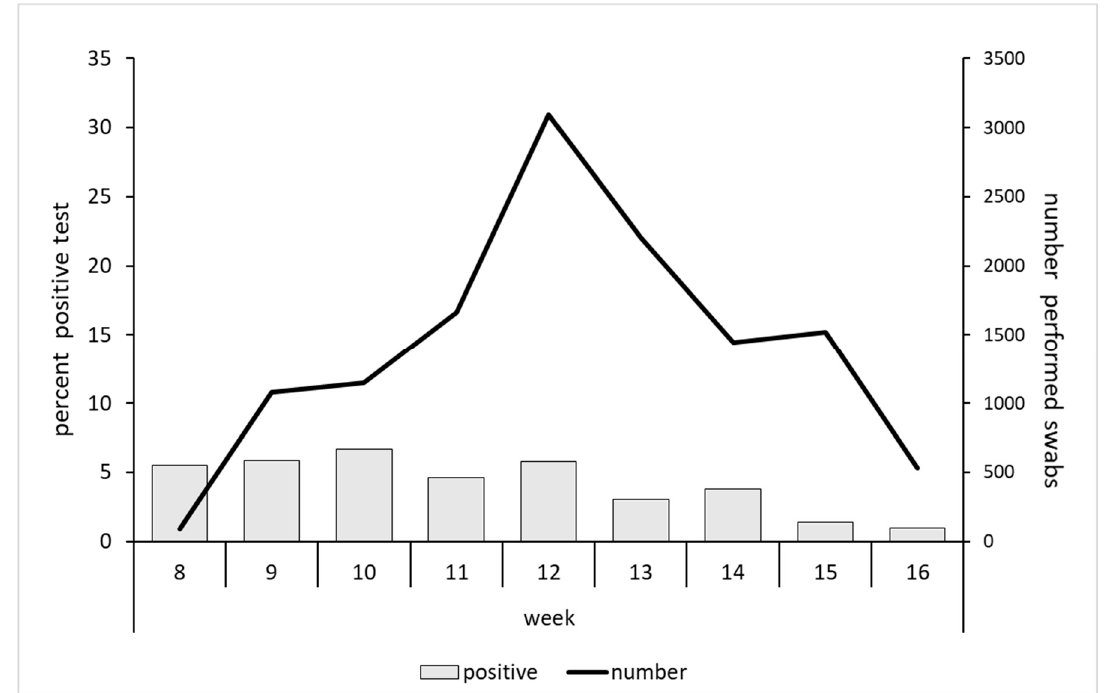
Figure 3. Number of performed nasopharyngeal swabs and percentage of SARS-CoV-2-positive tests according to weeks.